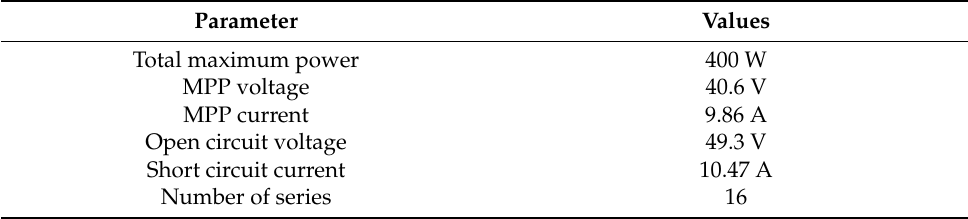
Table A1. Specification of the one PV Module